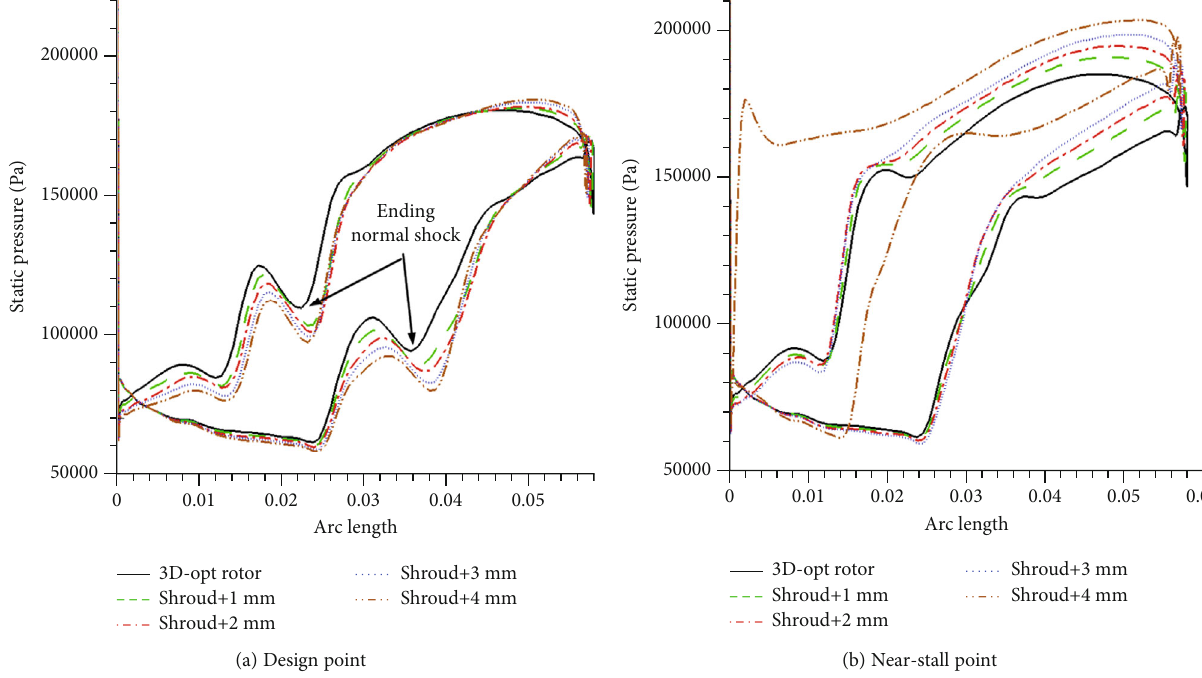
Figure 16: Distribution of surface static pressure at 90%